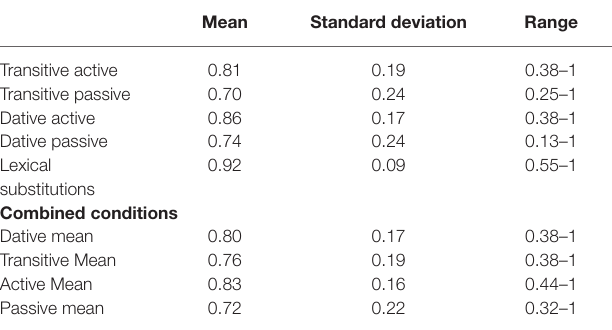
TABLE 5 | Descriptive statistics for performance on each trial type in the active- passive sentence comprehension task ( N = 56).